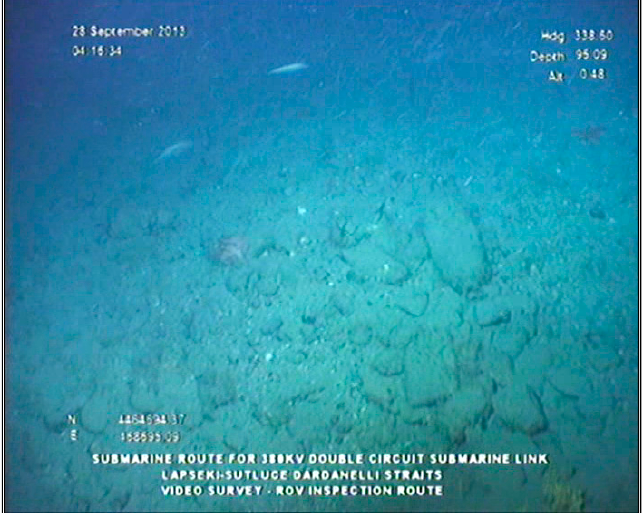
Figure 13. Very coarse gravel in the D category seabed.